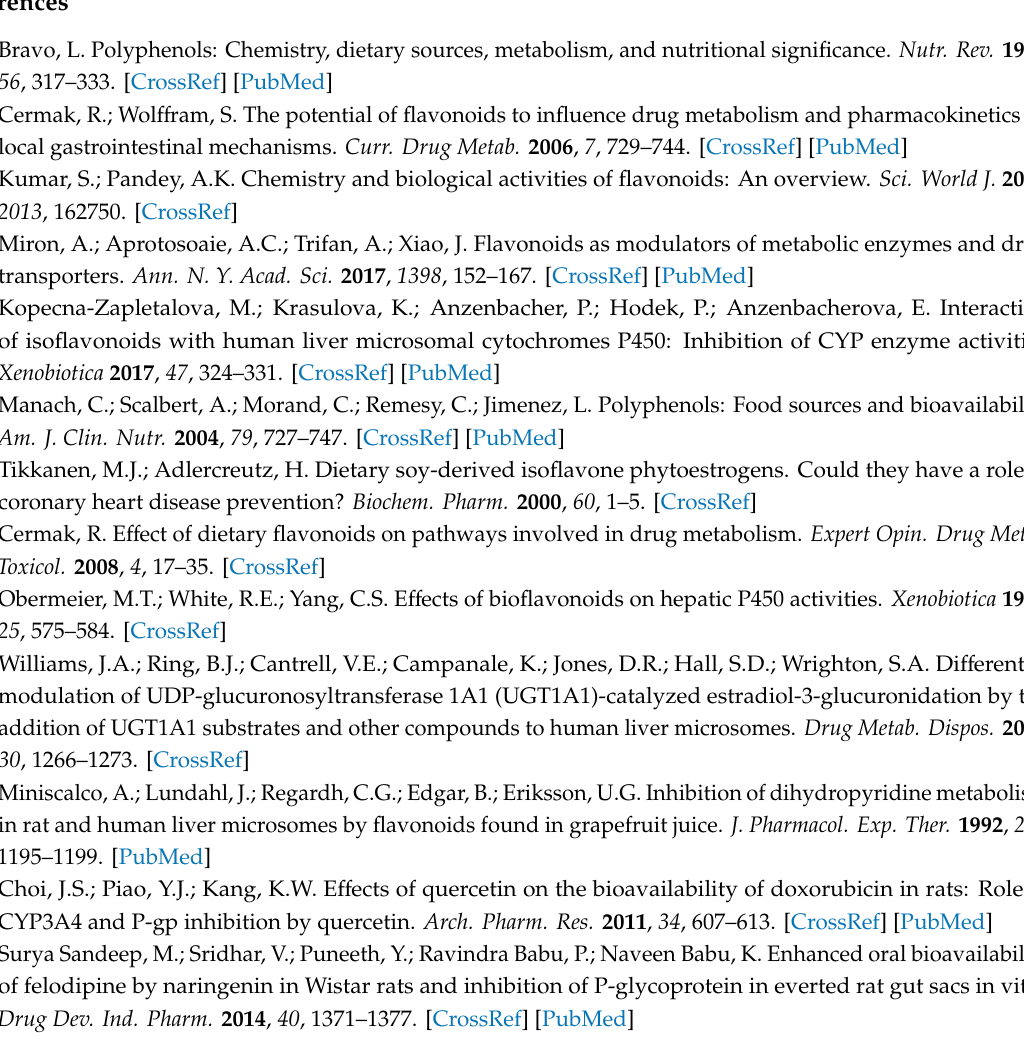
Figure S1: Representative Lineweaver–Burk plots obtained from a kinetic study of CYP1A2-catalyzed phenacetin O -deethylation (A), CYP2B6-catalyzed bupropion hydroxylation (B), CYP2C8-catalyzed amodiaquine N -deethylation (C), CYP2C8-catalyzed rosiglitazone 5-hydroxylation (D), CYP2C9-catalyzed diclofenac 4-hydroxylation (E), and CYP3A-catalyzed midazolam 1 (cid:48) -hydroxylation (F) in the presence of di ff erent concentrations of selamariscina A. Each data point shown represent the mean ± standard error in triplicate